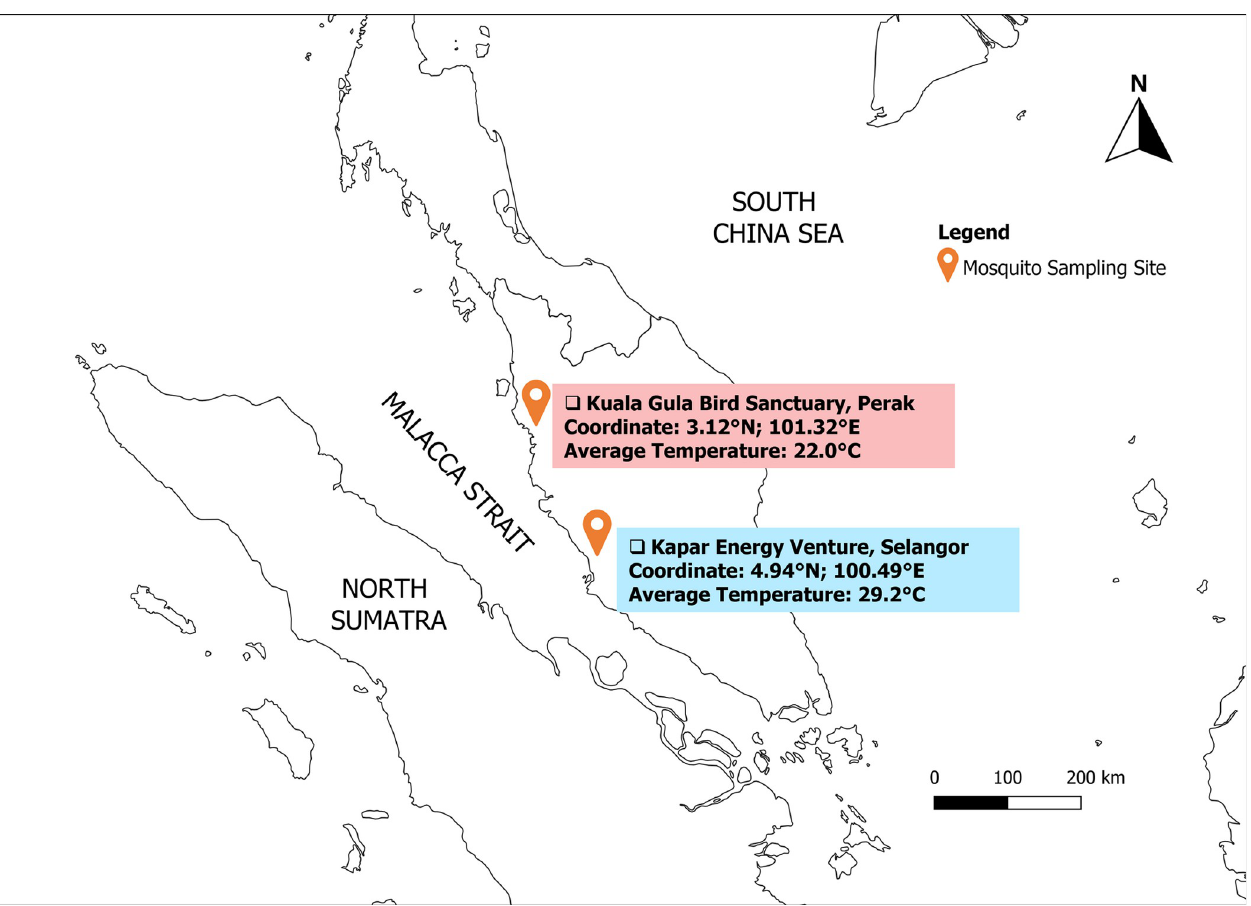
Fig 1. Sampling sites for mosquito collection. The wild bird’s migration sites and stopover in Malaysia used as sampling location of mosquitoes in this study [marked with orange pin]. The study location map was prepared using Natural Earth website: https://www.naturalearthdata.com/downloads/.